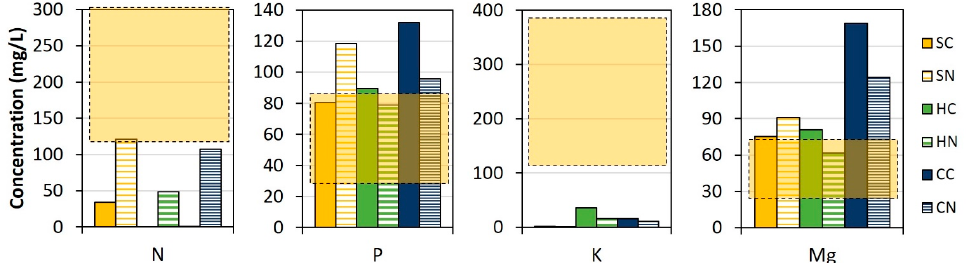
Figure 4. Nutrient concentration after DS dilution by FO in view of its further application in hydroponics and estimated optimal ranges (bars, ± 30% values from Table 2) with the optimal ranges (yellow squares). Reference for MgP salts: S, struvite; H, hazenite; C, cattiite. Reference for acids: C, citric acid; N, nitric acid.